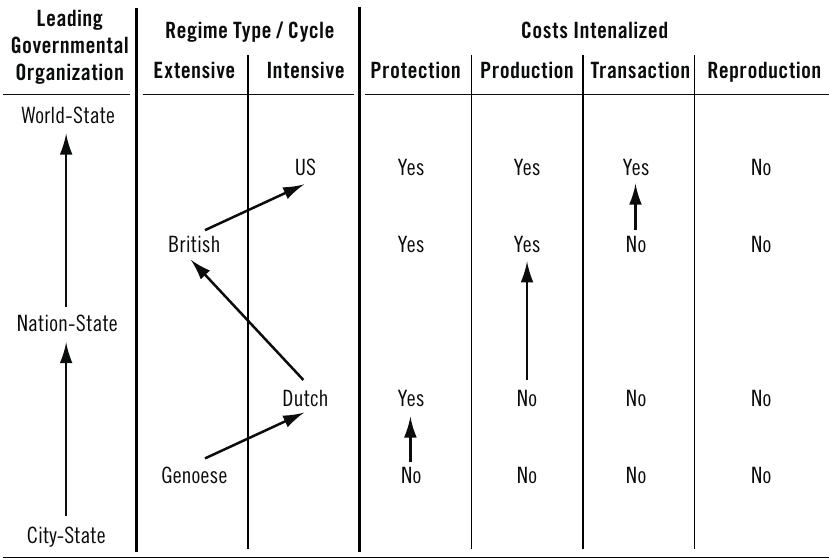
Figure 1 – Evolutionary Patterns of World